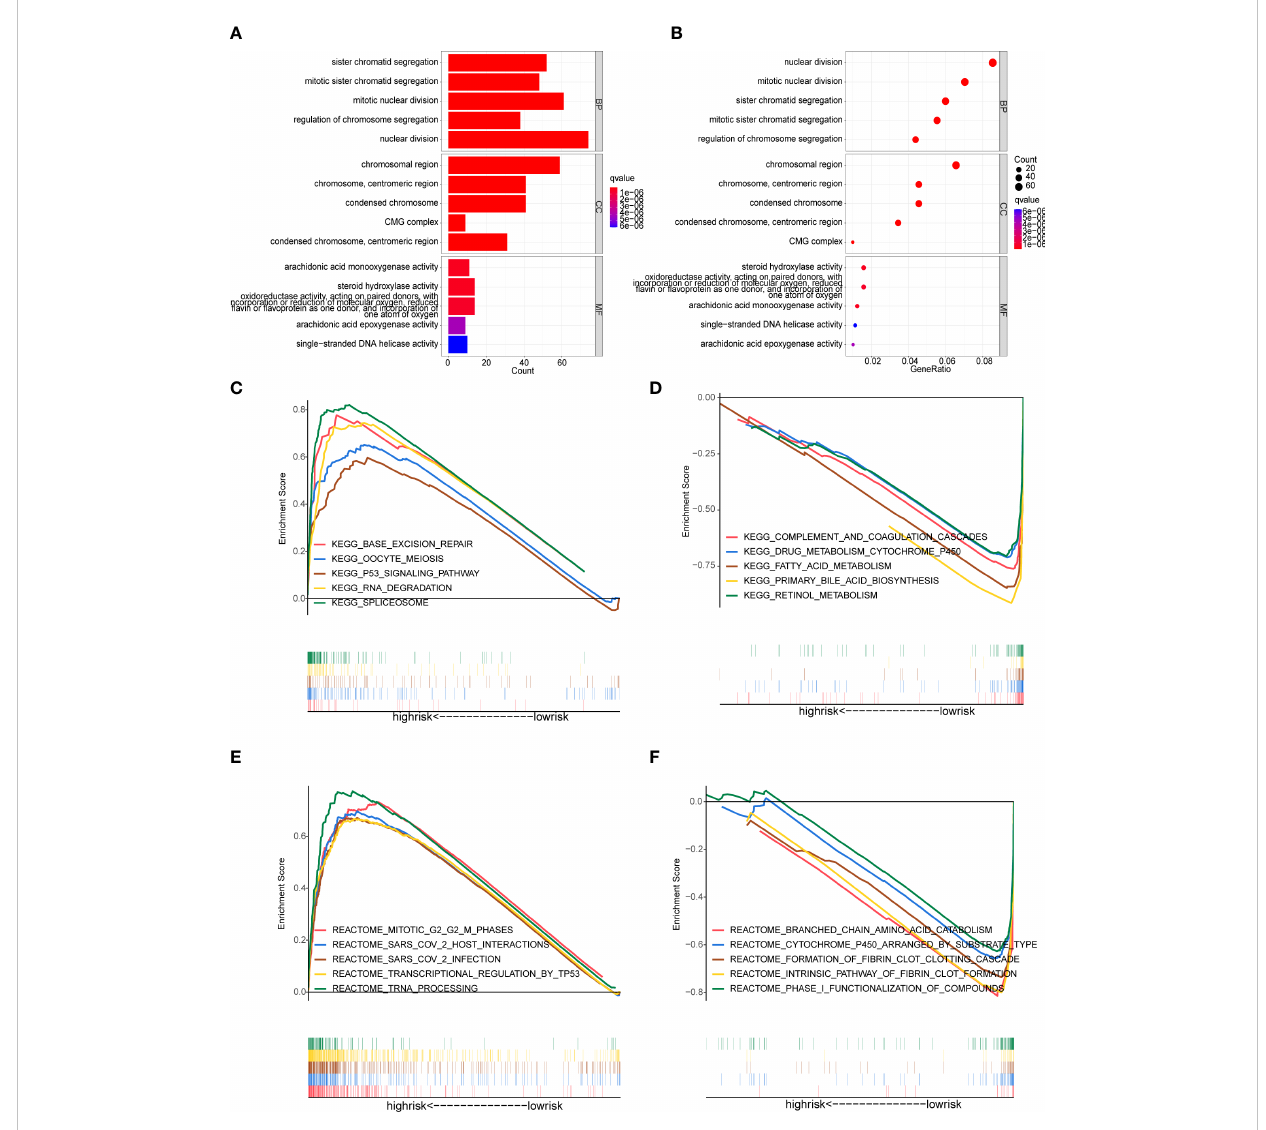
FIGURE 7 Functional enrichment analysis (A, B) GO enrichment analysis of the DEGs between the high- and low-risk groups. (C-F) Gene Set Enrichment Analysis (GSEA). (C, D) Enriched KEGG pathways in the high-risk and low-risk groups. (E, F) Enriched Reactome pathways in the high-risk and low- risk